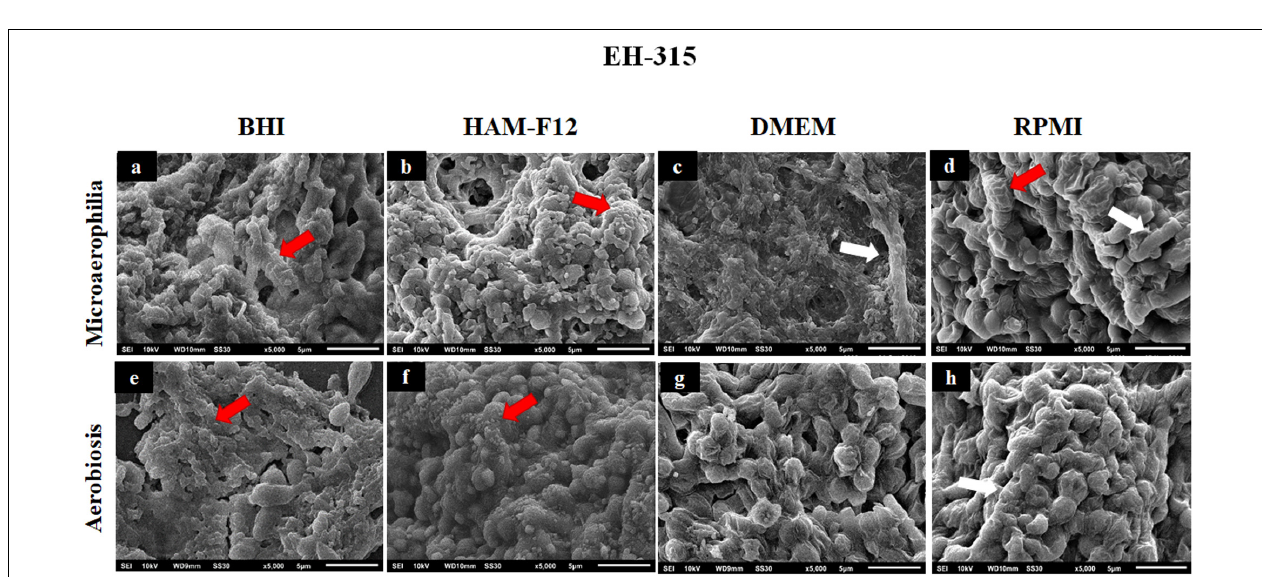
FIGURE 7 | Scanning electron microscopies of the biofilm of Histoplasma capsulatum formed by strain EH-315 in different culture media in the conditions of microaerophilia (a–d) and conditions aerobiosis (e–h) . The red arrows denote the extracellular matrices, while the white arrows denote some hyphae.